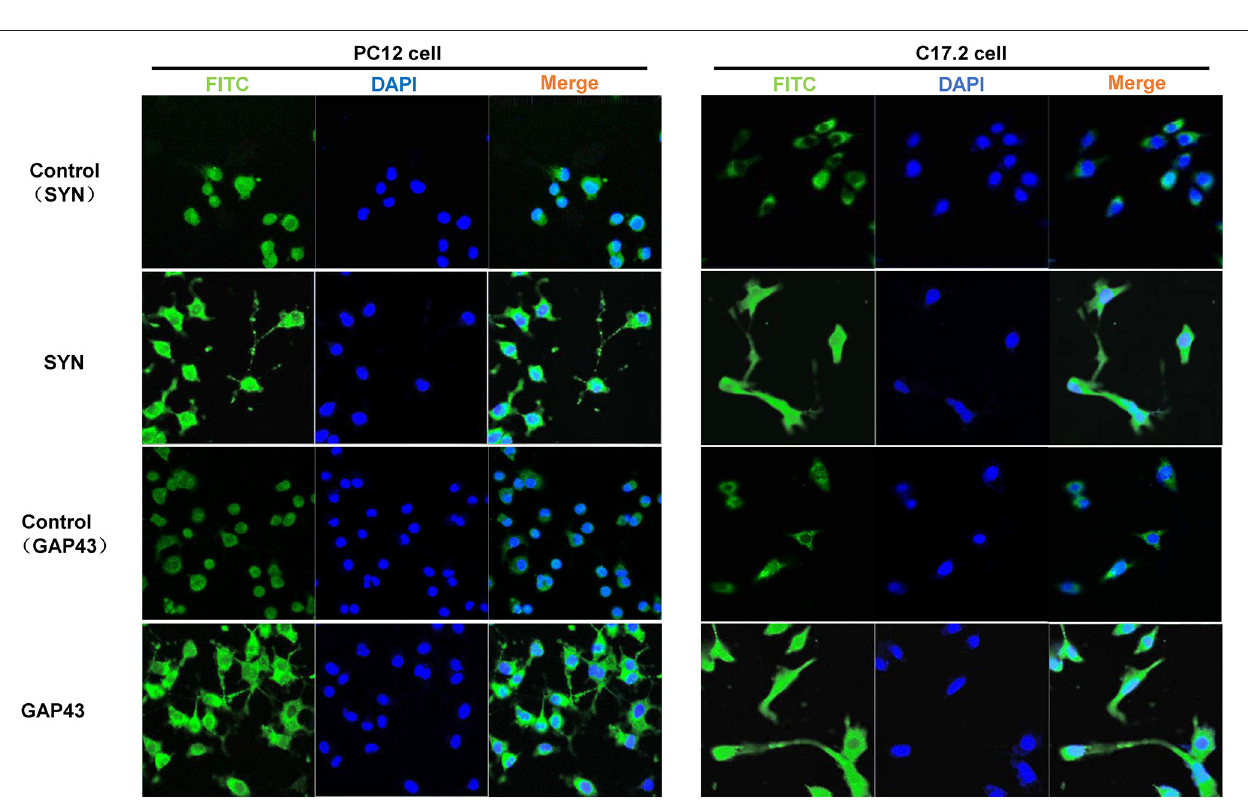
FIGURE 5 | Immunofluorescence detection of differentiation markers in PC12 cells and C17.2 cells treated with culture supernatant of M. smegmatis . PC12 cells and C17.2 cells were treated with 10% M. smegmatis culture supernatant for 48h Cells were immunofluorescence stained with GAP43 and SYN. Nuclear counterstaining was done with DAPI. Fluorescence was visualized with a laser-scanning confocal microscope (40 ×